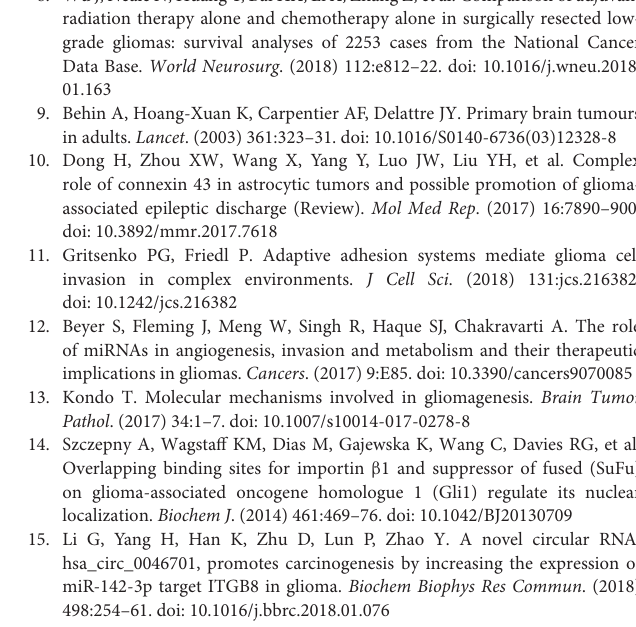
Figure S1 | The detection of migration and invasion abilities of A172, LN229, U87-MG, and U251 cell lines. Figure S2 | The detection of migration and invasion abilities of HEB and A172 cell lines transfected with hsa_circ_0088732 overexpression plasmids. ∗∗ P <